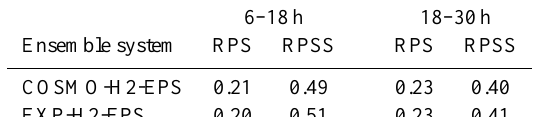
Table 1. Ranked probability score and skill score of the two ensem- bles computed in terms of 12h accumulated precipitation against SYNOP data.